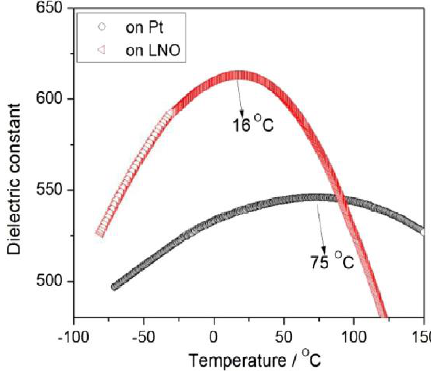
Figure 12. Dielectric constant as a function of temperature measured at frequency of 100 kHz for the BCZT thin films deposited on Pt(111) / Ti / SiO2 / Si substrate and LNO / Pt(111) / Ti / SiO 2 / Si substrate. Reprinted with permission from [60]. Copyright 2013 Elsevier.